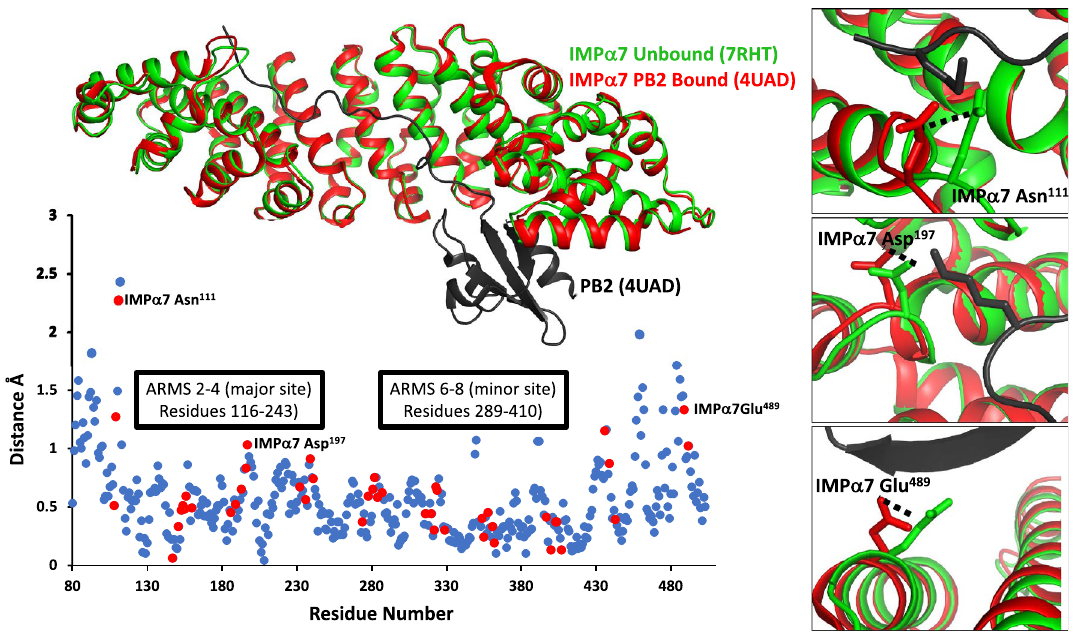
Figure 2. Structural alignment of IMPα7 in unbound (coloured green, PDB 7RHT) and bound (coloured red and PB2 NLS in black, PDB 4UAD 19 ) forms. Graph inset represents distance differences between bound and unbound structures. Red dots reflect the positions within IMPα7 mediating PB2 binding. Minor changes in the positioning of some residues (listed in the graph inset) were observed in the cargo bound form, and these are presented in the right panels.